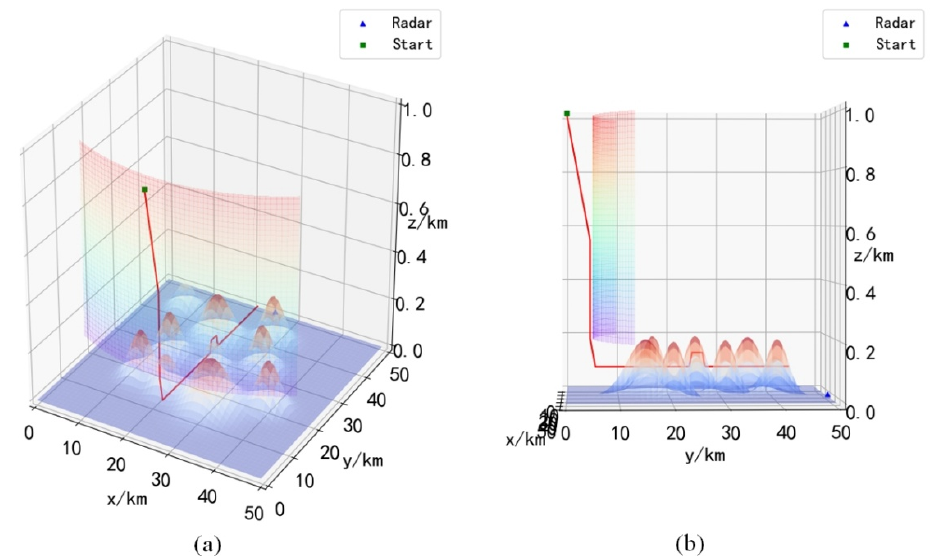
Figure 15. The path planning result in scenario 4. ( a ) is the full view of the path, ( b ) is the side view of the path.